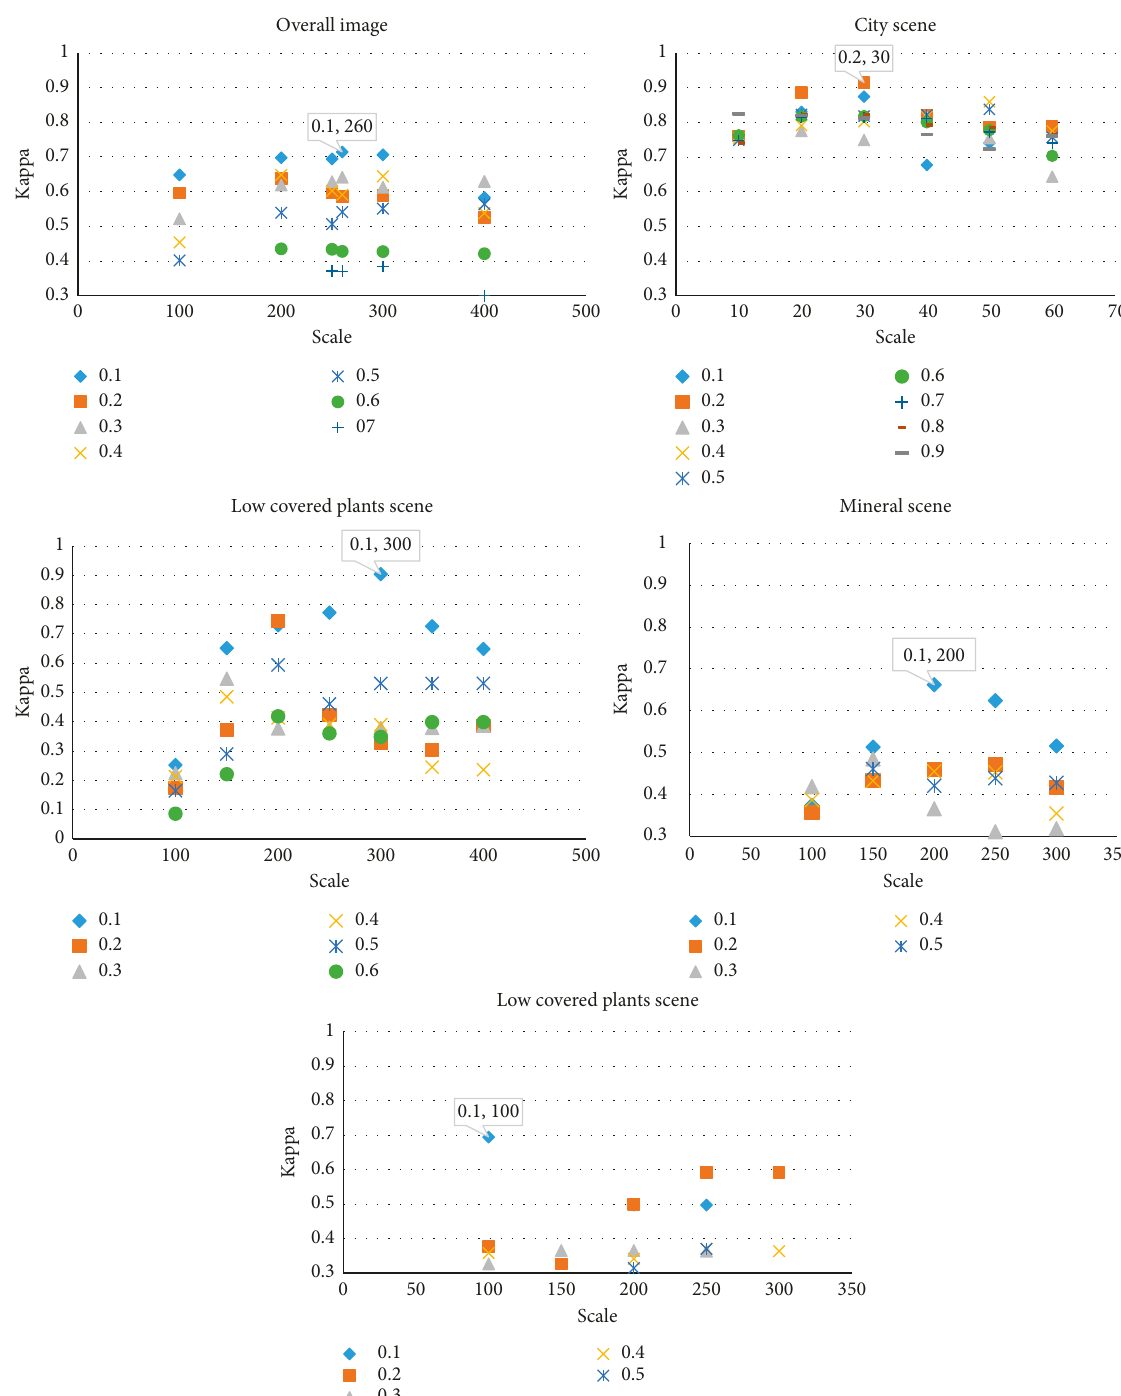
Figure 6: Scene and scene merged images’ kappa coefficients of image